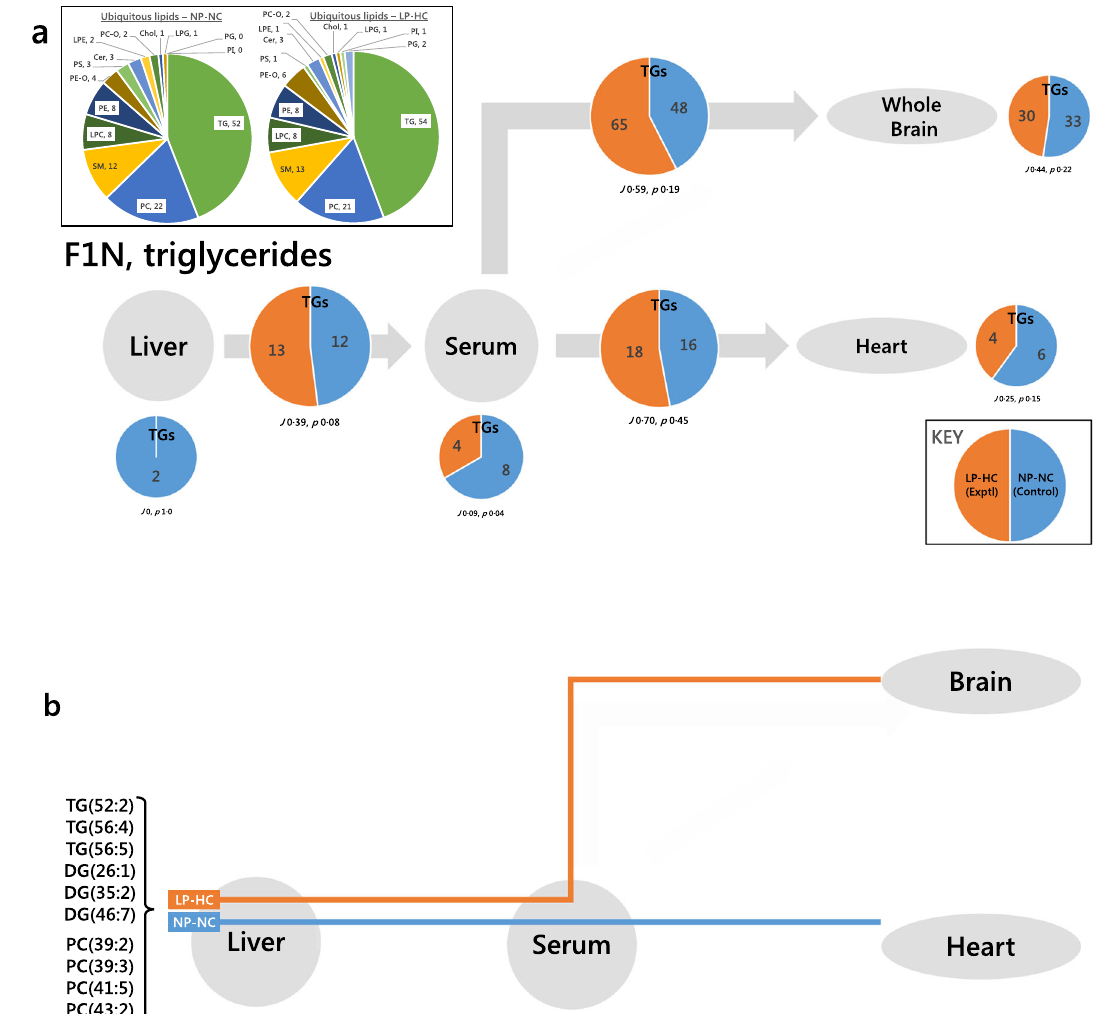
Fig. 3 Switch analyses of triglyceride variables in the neonatal F1 offspring (F1N) of fathers fed a normal (NP-NC) or a low-protein, high carbohydrate (LP-HC) diet, measured by mass spectrometry. a Traf fi c analysis of triglyceride variables; b , routing diagram of the switch analysis of triglyceride (measured in positive ionisation mode) and phosphatidylcholine (measured in negative ionisation mode) variables in F1 neonatal mice re-routed from the serum-heart in the control group to the serum-brain in the experimental group. TG and PC variables on the serum-heart axis in the control (NP-NC, blue) group of F1Ns that are found on the serum-brain axis of the experimental (LP-HC, orange) group of F1Ns but not their serum-heart axis. The pie charts in the insert show the number of ubiquitous lipid variables for that network, for each phenotype. Larger pie charts represent lipids found in two adjacent compartments ( B -type lipids). Smaller pie charts represent lipids found in isolated in compartments ( U -type lipids). J represents the Jaccard-Tanimoto coef fi cient for the comparison, with accompanying p value, as a measure of the similarity between the variables identi fi ed in the two phenotypes for each comparison. The p value shown represents the probability that the difference between the lists of variables for the two phenotypes occurred by random chance. Orange is used for the LP-HC group, whereas blue is used for the NP-NC group. Cer, ceramide; Chol, cholesterol; DG, diglyceride (water-loss product from fragmentation in source); LPC, lyso -phosphatidylcholine; LPE, lyso -phosphatidylethanolamine; LPG lyso -phosphatidylglycerol; PA, phosphatidic acid; PC, phosphatidylcholine; PC-O, phosphatidylcholine plasmalogen; PE, phosphatidylethanolamine; PE-O, phosphatidylethanolamine plasmalogen; PG, phosphatidylglycerol; PI, phosphatidylinositol; PS, phosphatidylserine; SM, sphingomyelin; TG, compartments ( B type lipids, e.g. liver-serum axis) or ubiqui- unique to both groups, whereas p > 0.5 meant that only one group tously ( A type lipids). This, therefore, represented lipids that were could have any unique variables. Thus, a JTC of 0.67 with a p of 1 switched on or off with respect to a measurement threshold. The Switch Analysis requires only straightforward lipidomics data rendered as zero or non-zero values, e.g. relative abundance. The Switch Analysis of TGs in the F1N group is shown in Fig. 3a. Pie chart segments show the number of TG variables in each phe- notype. Jaccard-Tanimoto coef fi cients (JTC, with accompanying p values) were used to characterise the similarity between the compared groups. The JTC indicated the proportion of variables that appeared in the two groups 24,25 whereas the p value indicated what differentiated them; a p < 0.5 indicated there were variables